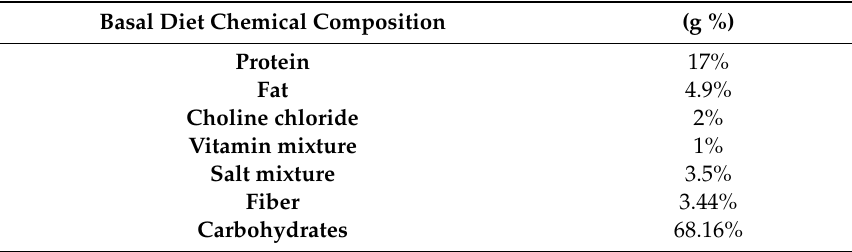
Table 1. Chemical composition of basal